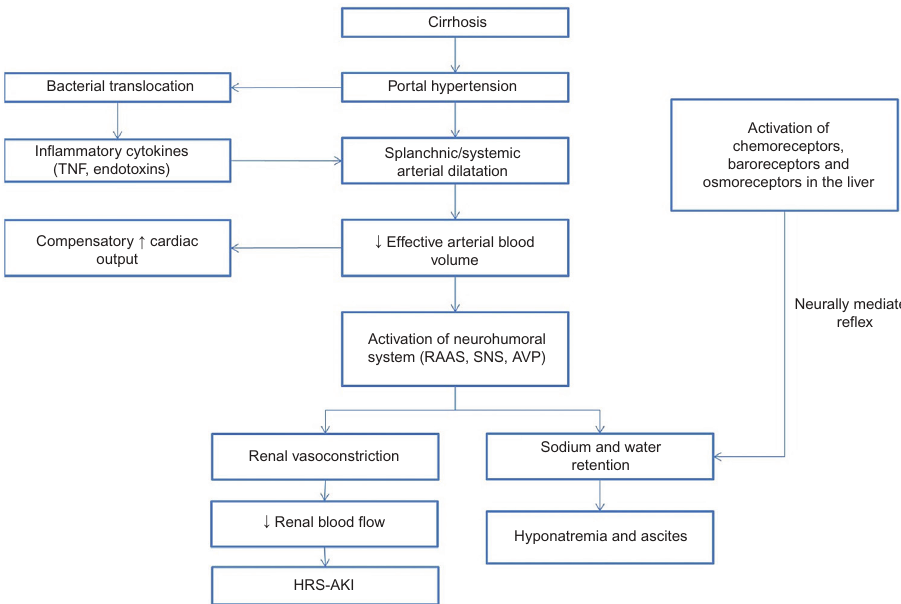
Figure 1. Proposed mechanisms for pathophysiology of hepatorenal syndrome. AVP, arginine vasopressin; RAAS, renin-angiotensin-aldosterone system; SNS, sympathetic nervous system; TNF, tumour necrosis